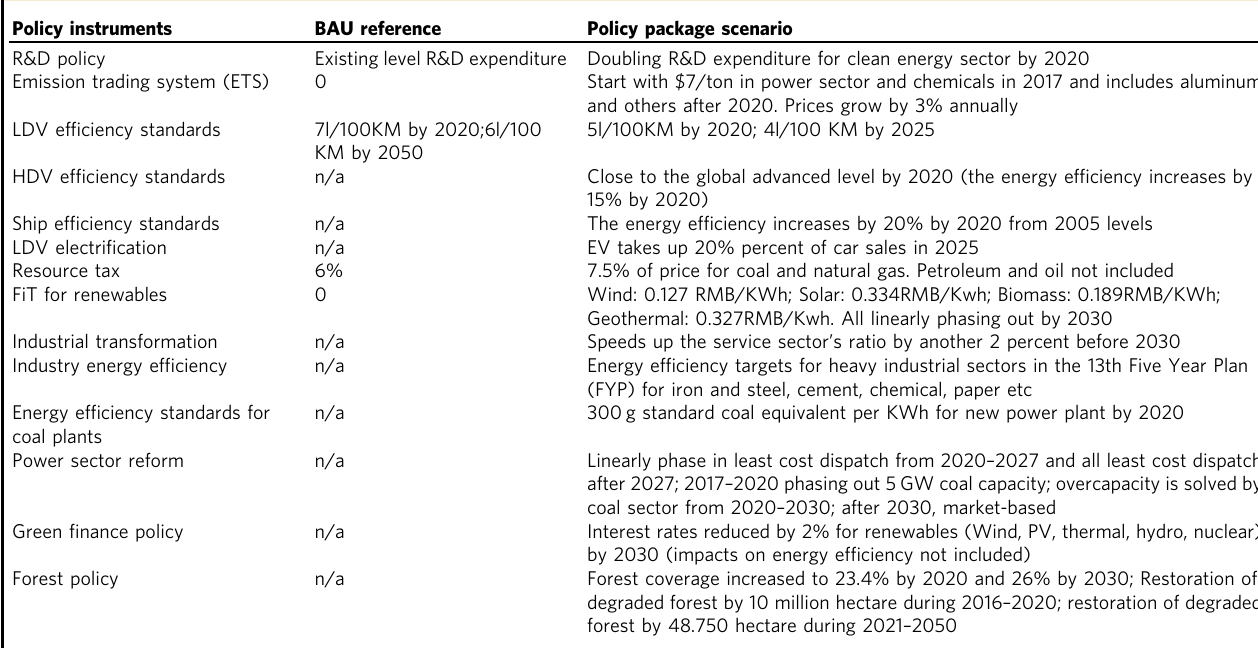
Table 2 Policy instrument comparison between the BAU reference case and the policy package scenario Policy instruments